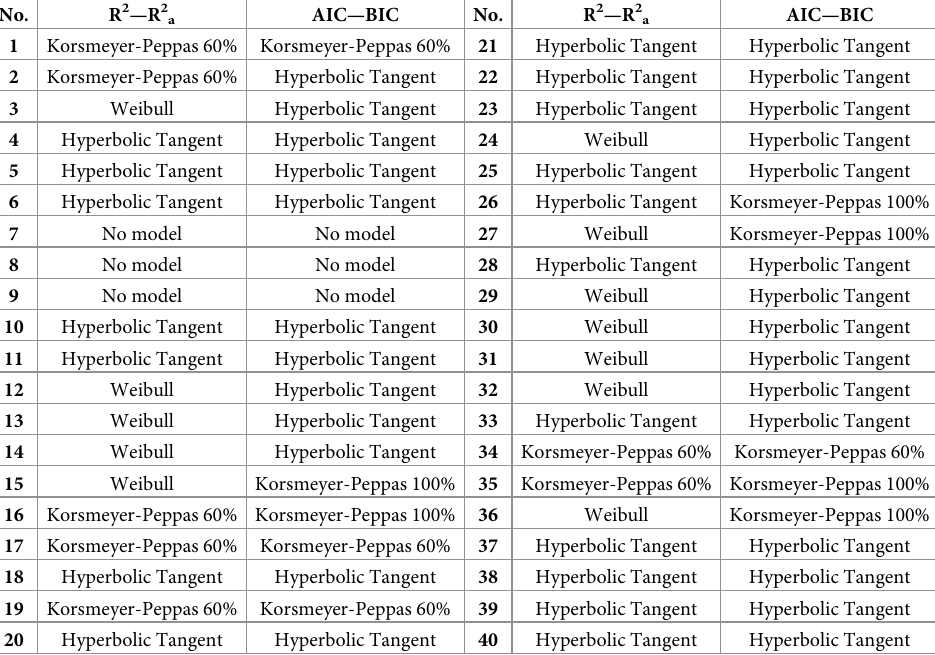
Table 3. Best fit for each data set according to R 2 , R 2 a , AIC and BIC.